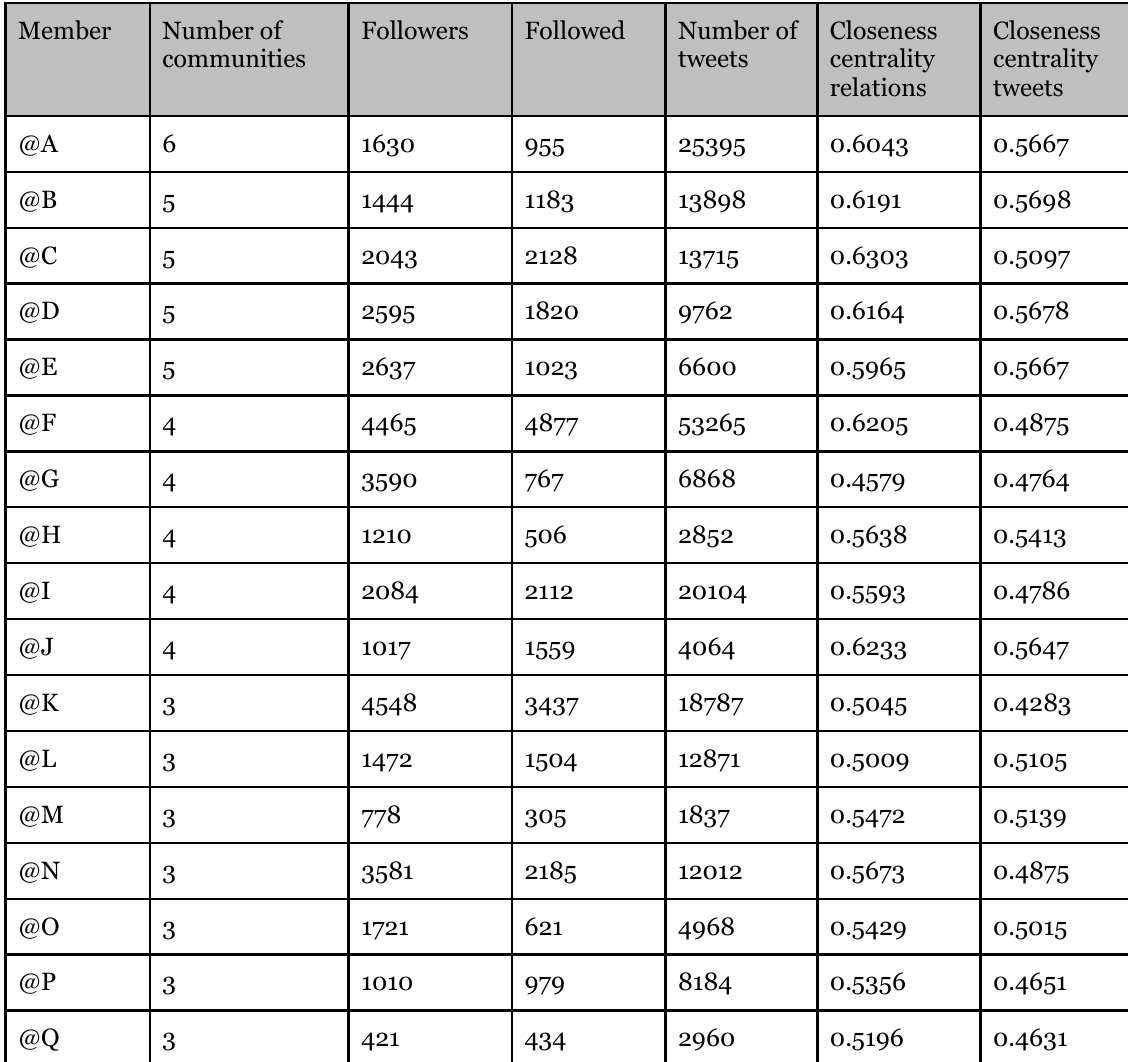
Table 5 Profile of Members Belonging to Three or More Communities Member Number of Followers communities